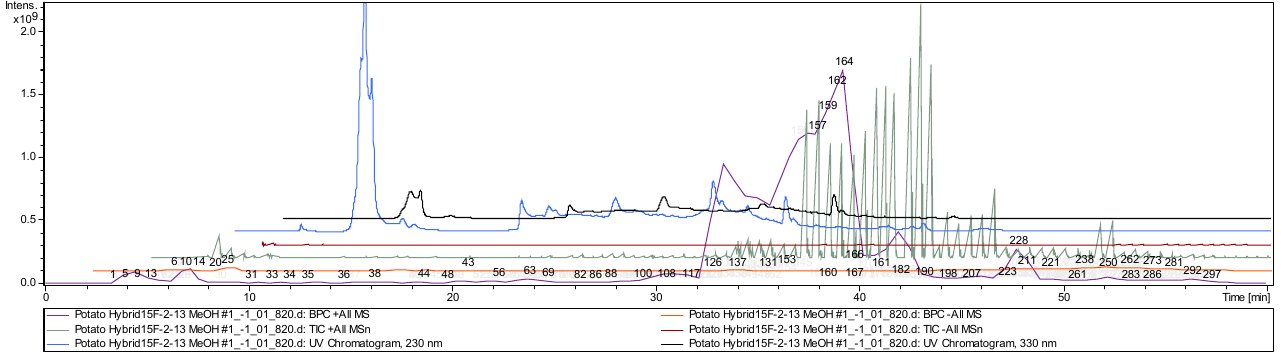
Figure 1. Chemical profiles of the S. tuberosum L. (variety Hybrid 15/F-2-13) sample represented total ion chromatogram from MeOH-extract.